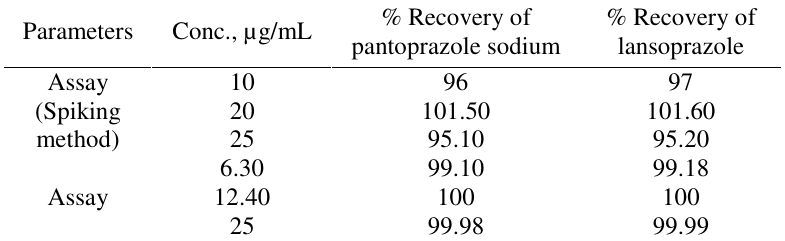
Table 1. Accuracy/recovery of pantoprazole sodium and lansoprazole.